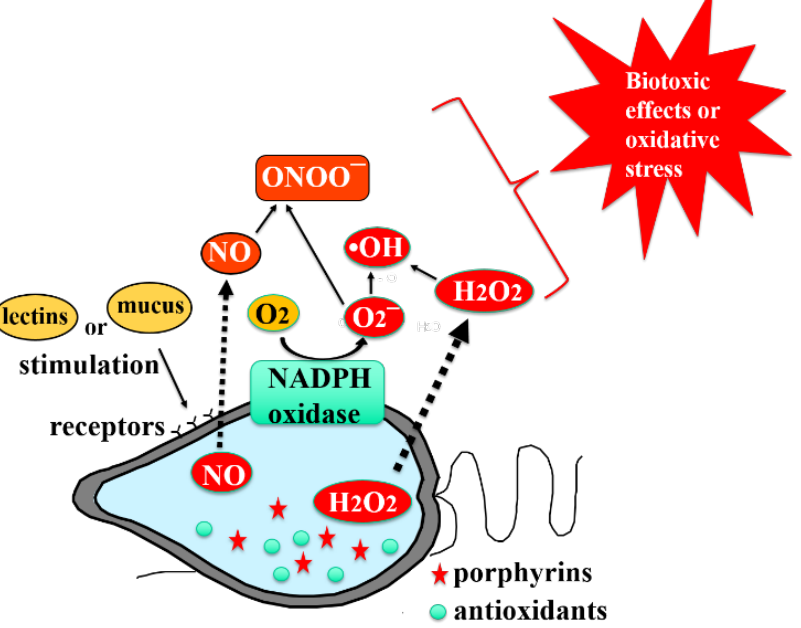
Figure 1. Production of reactive oxygen species (ROS) and other bioactive molecules in Chattonella.